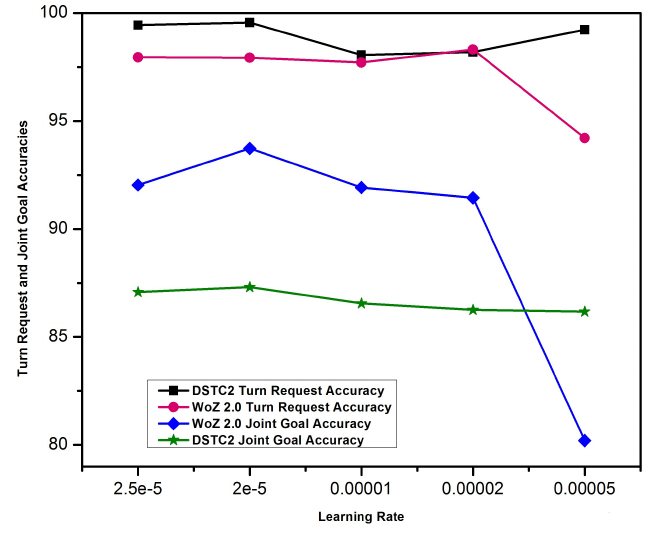
Figure 5. Impact of Learning